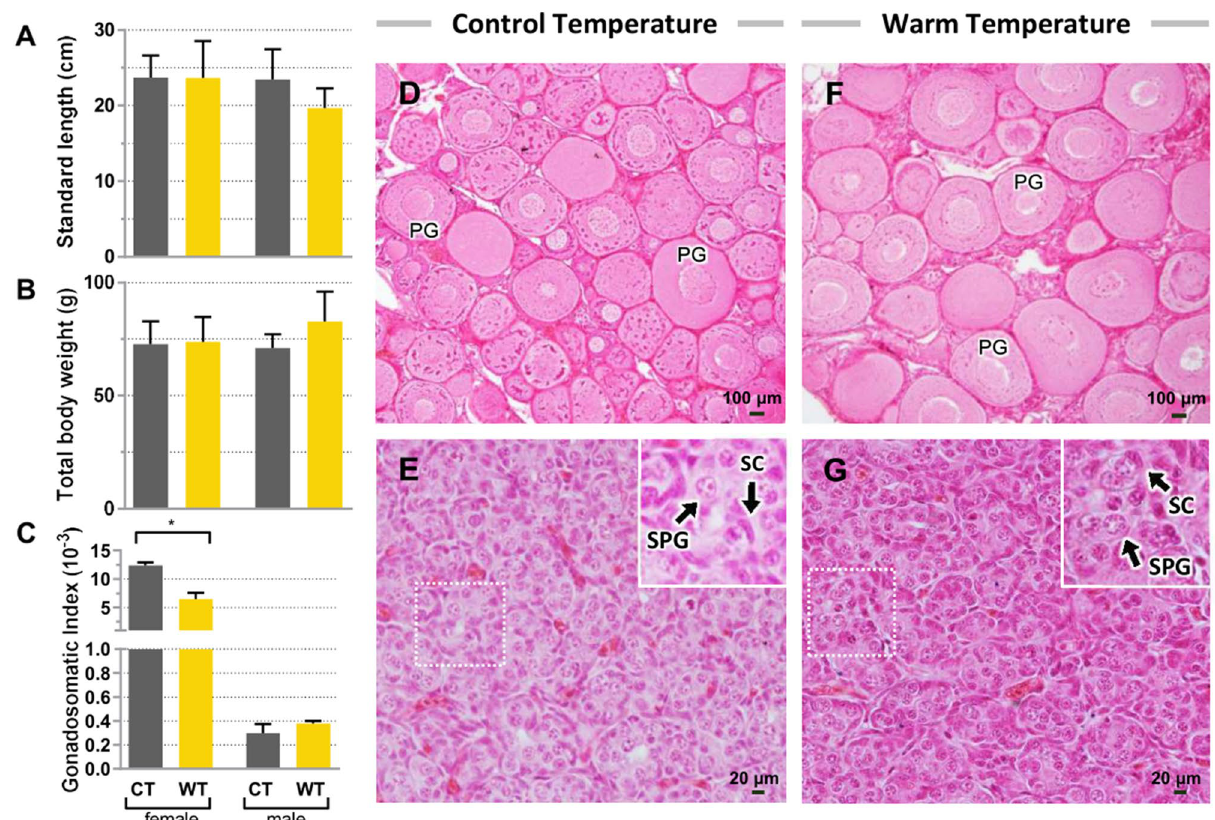
Figure 2. Growth and reproductive parameters of F0 juveniles from control (CT) and warm temperature (WT) groups. ( A ) Total body weight, ( B ) standard length, and ( C ) gonadosomatic index in females and males after thermal treatment. ( D , F ) Ovary and ( E , G ) testis histology from F0 juvenile fish three months after thermal treatment. The enlarged images in E and G refer to the respective dotted boxes. PG: primary growth oocytes; SPG: spermatogonia; CS: Sertoli cells. Histograms are presented as mean ± S.E.M. Asterisks (*) indicate significant difference for p < 0.05. Data were analyzed in GraphPad Prism (version 5.02 for Windows, GraphPad Software, La Jolla California USA, www. graph pad. com).